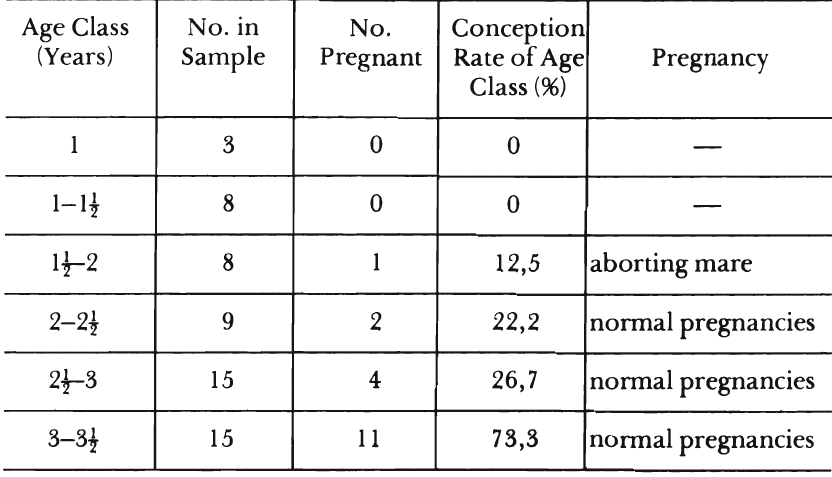
Age-specific conception rates for a sample of 58 young Burchell's zebra mares col lected in the Central District of the Kruger National Park between 1969 and